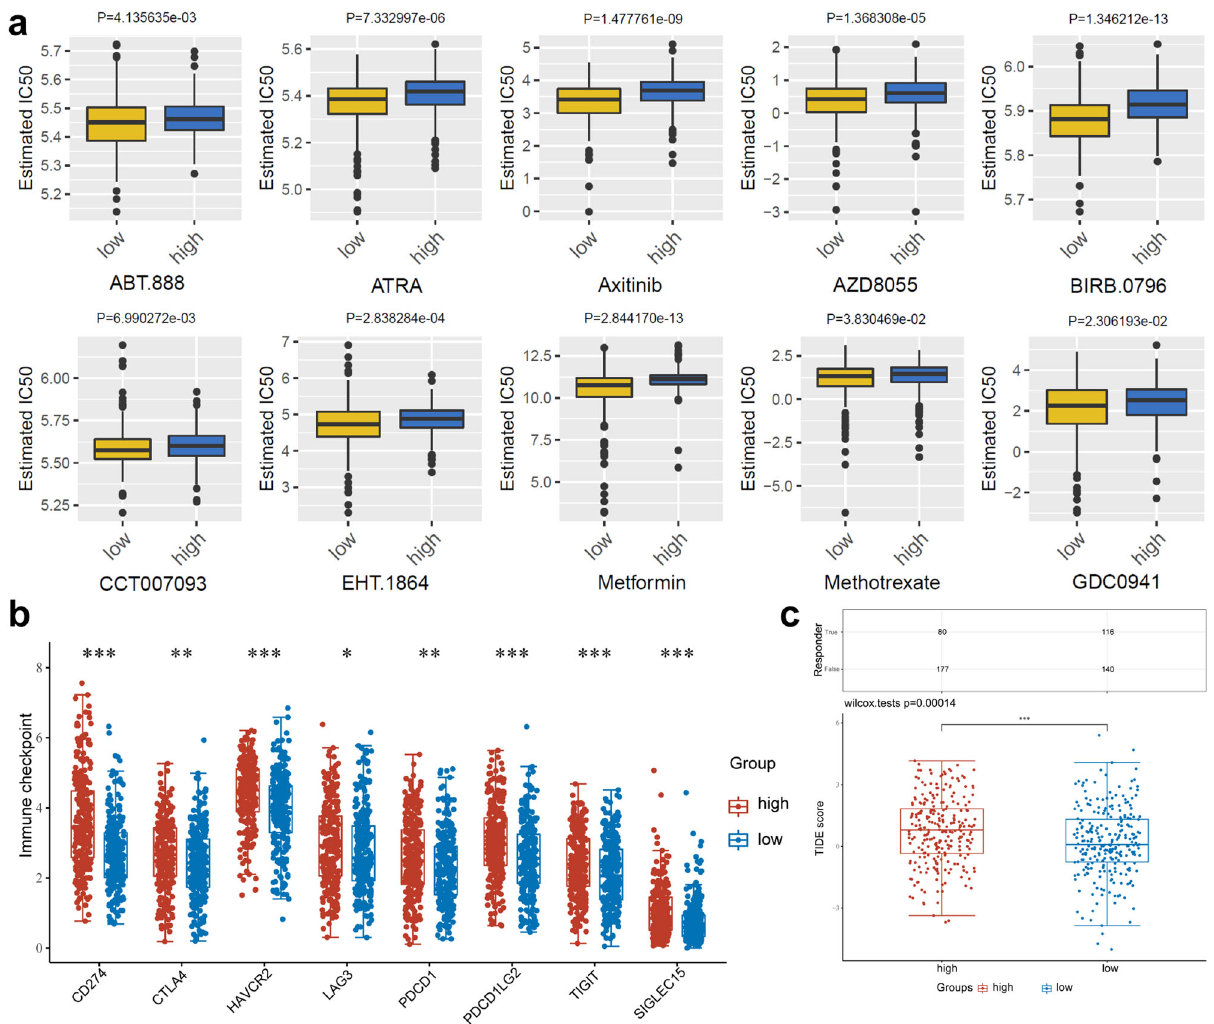
Fig. 7 Immune in fi ltration and response of high- and low- GPR87 patients to chemotherapy and immunotherapy. a The box plots of the estimated IC50 for ten common chemotherapeutic agents for high- and low- GPR87 expression. b Distribution of immune checkpoint expression in patients with high- and low- GPR87 expression. c The box plots of the TIDE scores for immunotherapy response for high- and low- GPR87